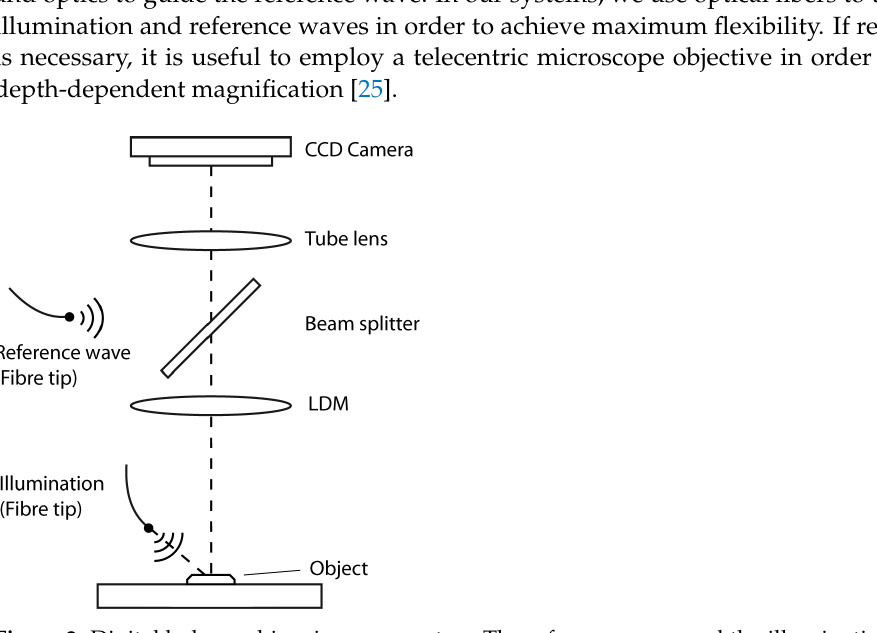
Figure 2. Digital holographic microscope setup: The reference wave and the illumination are pro- vided by an optical fiber. The object and reference wave are superposed using a beam splitter between the long distance microscope objective (LDM) and the tube lens. From the recorded interference pattern, it is possible to refocus the object subsequent to the measurement by means of computational